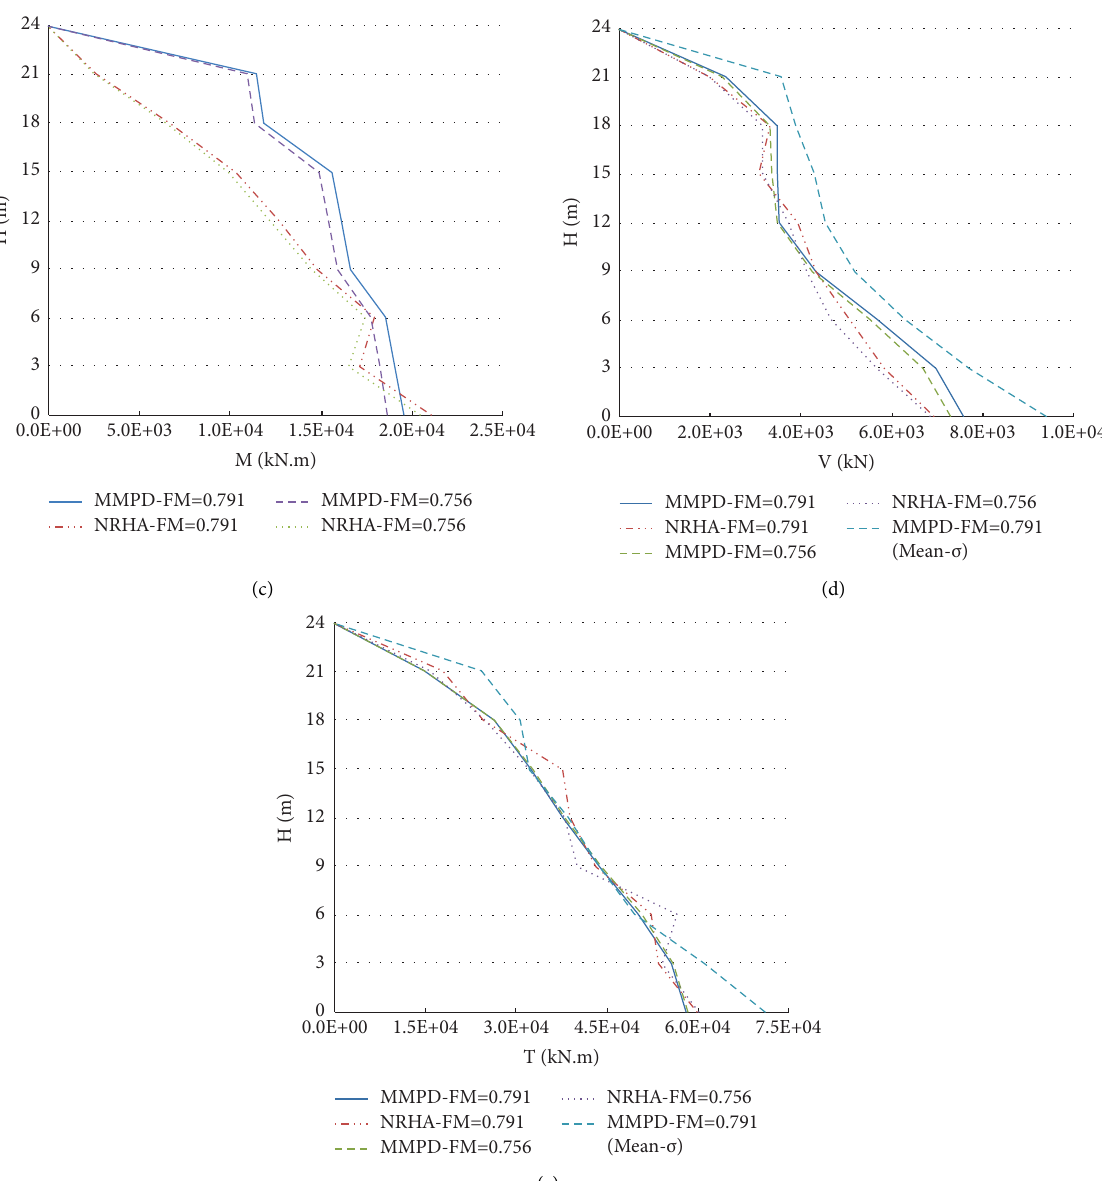
Figure 20: Building B2 under LANDERS record with diferent distributions of reinforcements: (a) comparison between NRHA and interstorey drifts limit, (b) NRHA fexural moment demands and MMPD fexural capacities of 30cm wall, (c) NRHA fexural moment demands and MMPD fexural capacities of 20cm wall, (d) NRHA/approximated MMPD shear demands, and (e) NRHA/approximated MMPD torsional